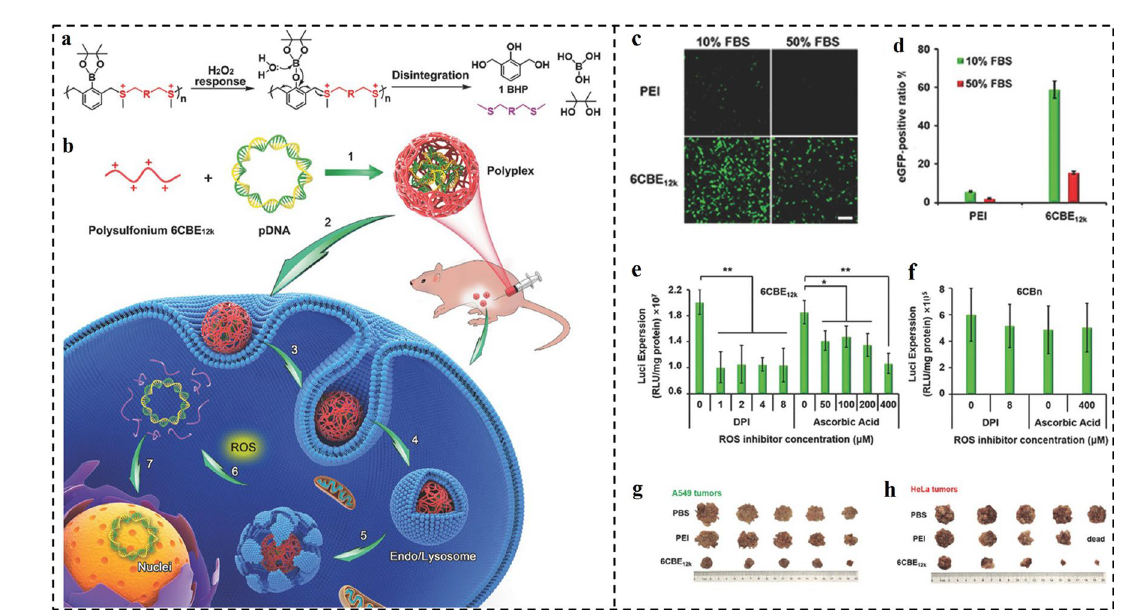
Fig. 10 a , b ROS-responsive disintegrable polysulfonium and its polyplex for intraperitoneal gene delivery. c , d Comparison of EGFP expres- sion mediated by PEI 25k ( N/P = 7) or 6CBE 12k ( S/P = 60) polyplexes. e , f Effects of DPI on luciferase expression mediated by e ROS-responsive 6CBE 12k polyplexes ( S/P = 60) and f ROS-insensitive 6CBn polyplexes ( S/P = 8). g , h Images of A549 and Hela tumors in each group [170]. Copyright 2017, WILEY–VCH